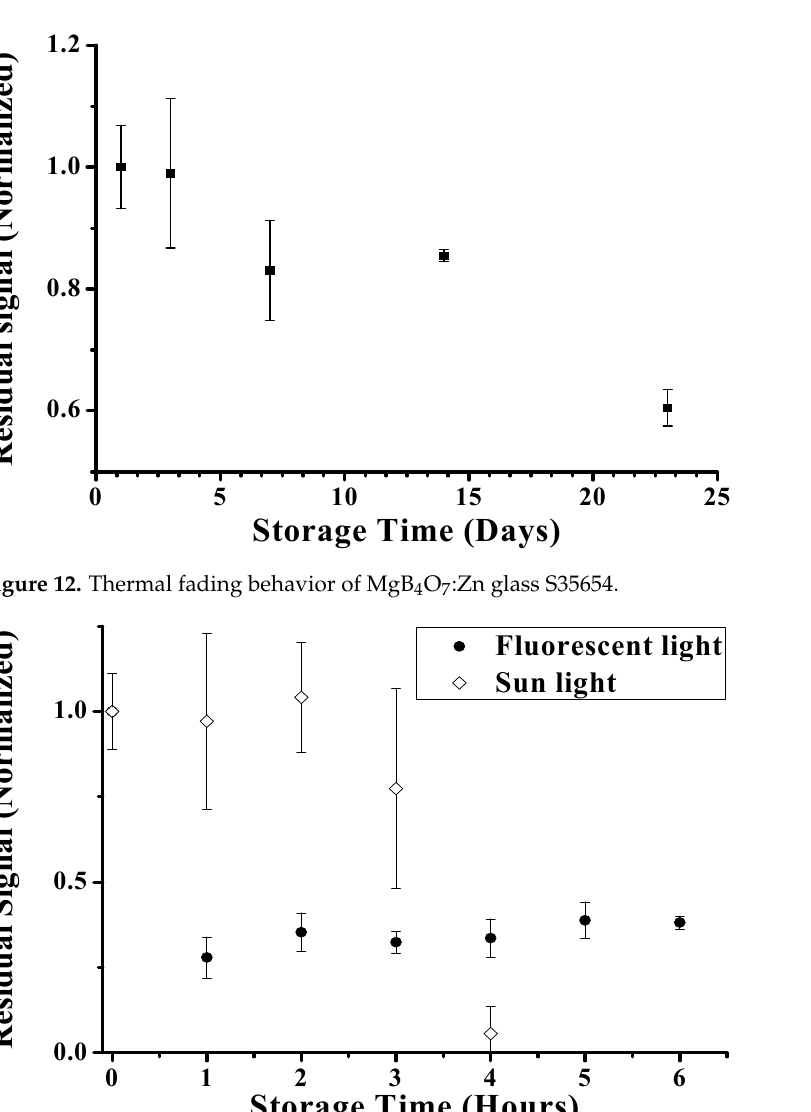
Figure 13. Optical fading behavior of MgB 4 O 7 :Zn glass S35654.